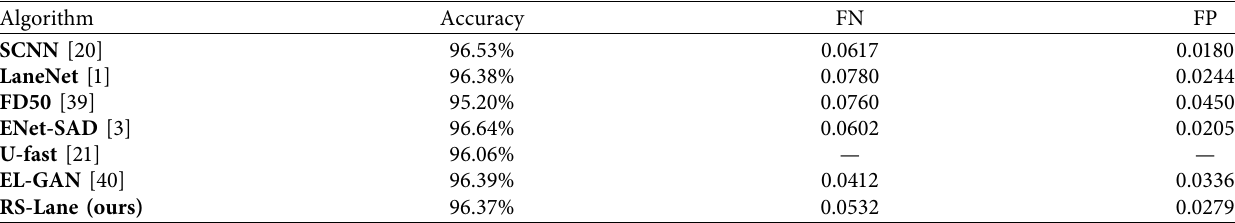
Table 3: Comparison on TuSimple testing